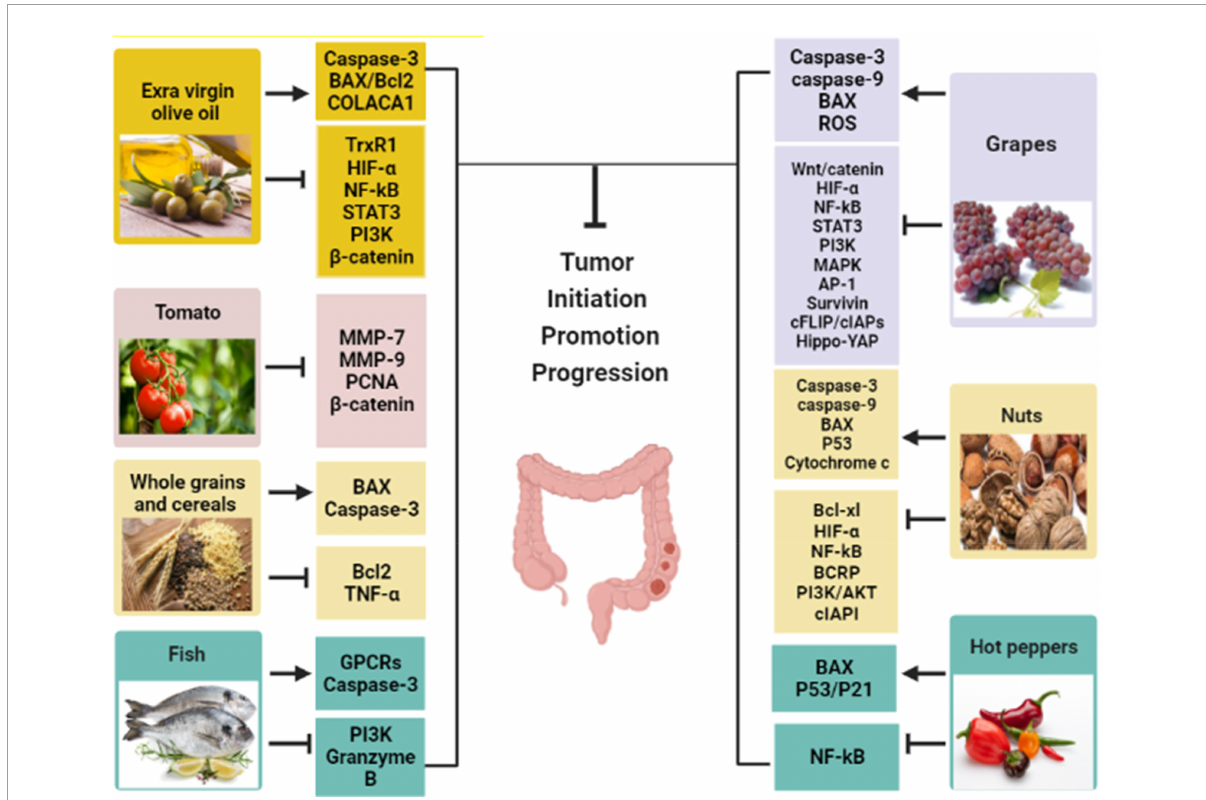
FIGURE5 The Mediterranean diet components with their effects on cancer biomarkers. ( → , activation; (cid:62) , inhibition; ROS, reactive oxygen species; TNF- α , tumor necrosis factor-alpha; IL, interleukin; MMP-9, matrix metalloproteinases-9; BAX, Bcl-2-associated X protein; Wnt, wingless-related integration; PI3K, phosphoinositide 3-kinase; PCNA, proliferating-cell nuclear antigen; TrxR1, thioredoxin reductase 1; COLACA1, colorectal cancer associated-1 gene; Bcl2, B-cell lymphoma 2; GPCRs, G protein-coupled receptors; MAPK, mitogen-activated protein kinase;